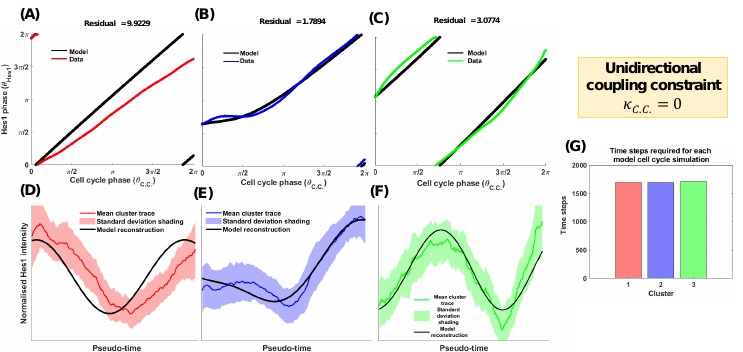
Figure A1. Results of the solutions to the model Equation (5) with the constraint κ C.C. = 0 when ( i ) ( i ) θ is optimised to the data vector Θ , i = 1,2,3, frequency parameters are set as ω Hes1 = 24 − 1 Hes1 Hes1 ( i ) and ω C.C. = 27 − 1 . ( A – C ) Square torus diagram trajectories of solutions θ , i = 1, 2, 3 superimposed Hes1 over data trajectories from Figure 2B. ( D – F ) Psedo-time plots of rebuilt Hes1 dynamics found via (cid:16) (cid:17) ( i ) θ cos , i = 1,2,3 superimpsoed over mean traces from Figure 2A. In ( A – F ), the black lines Hes1 denote the model results, coloured lines denote the data (red: cluster 1, blue: cluster 2 and green: cluster 3), and in ( D – F ), the shaded areas denote the standard deviations of the data. ( G ) Bar chart of cell cycle duration predictions from the simulation for each cluster case.